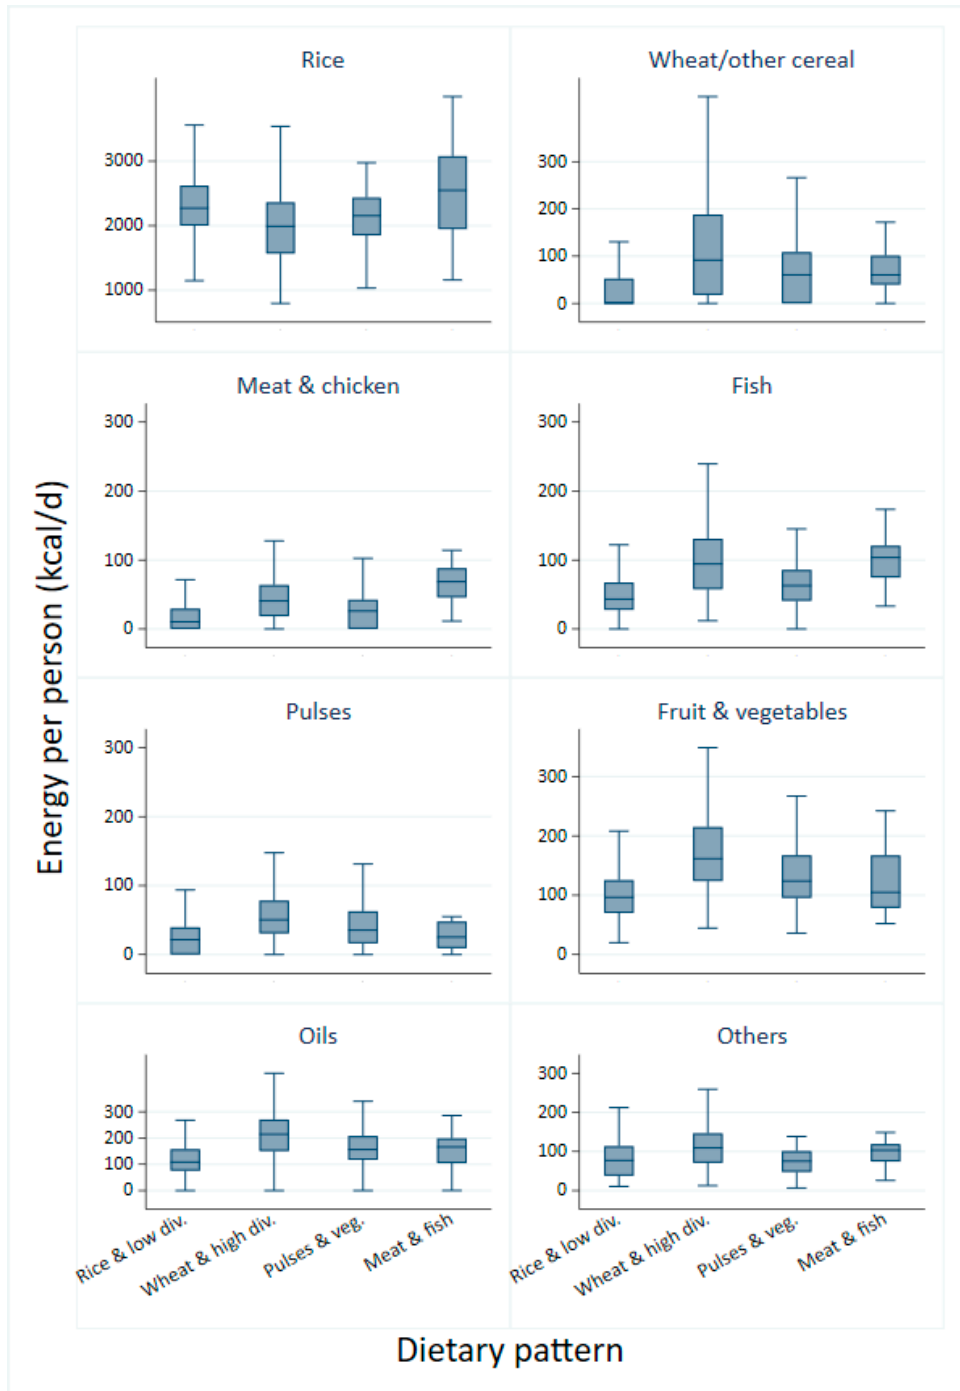
Figure 1. Mean energy from consumption of food groups by dietary pattern.